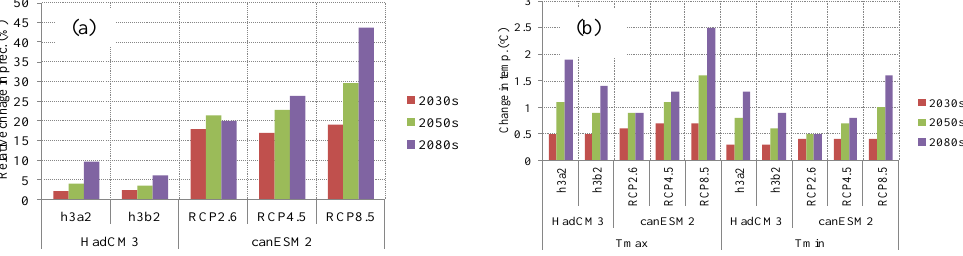
Figure 8. (a) Relative change of mean annual precipitation, and (b) change of mean annual T max and T min for three time periods compared to the baseline period of UBNRB using SDSM for HadCM3 and canESM2 GCMs under different scenarios. Table 4. Performance measure and ranking of models during the baseline period (1984–2011) for evaluation metric RMSE. RMSE value Equally weighted score Varying weights score